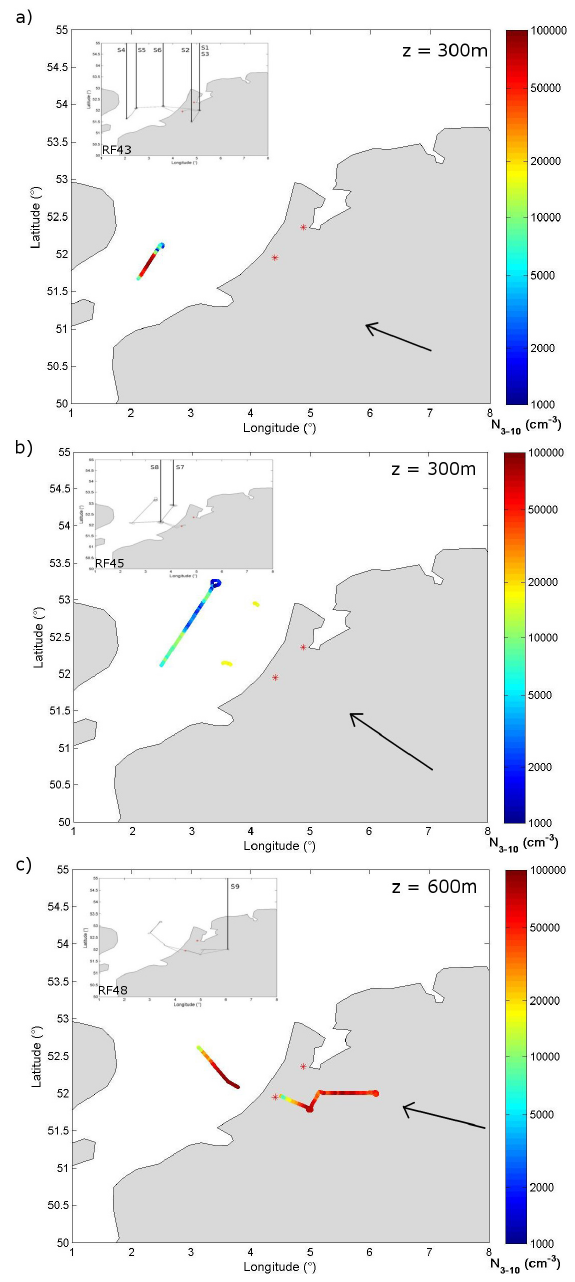
Fig. 3. Horizontal cross sections showing nucleation mode aerosol concentrations of Group I events within the size range of 3–10nm along the ATR-42 flight trajectories during research flights (a) RF43 on 05 May, (b) RF45 on 08 May, and (c) RF48 on 11 May. Only N 3 − 10 at a constant flight leg altitude, indicated on each figure, are represented. The black arrows represent the mean direction of the air mass (deduced from back-trajectories calculated with Hysplit (http://ready.arl.noaa.gov/HYSPLIT.php). The vertical black lines refer to the ATR-42 sounding numbers as they appear in Fig.